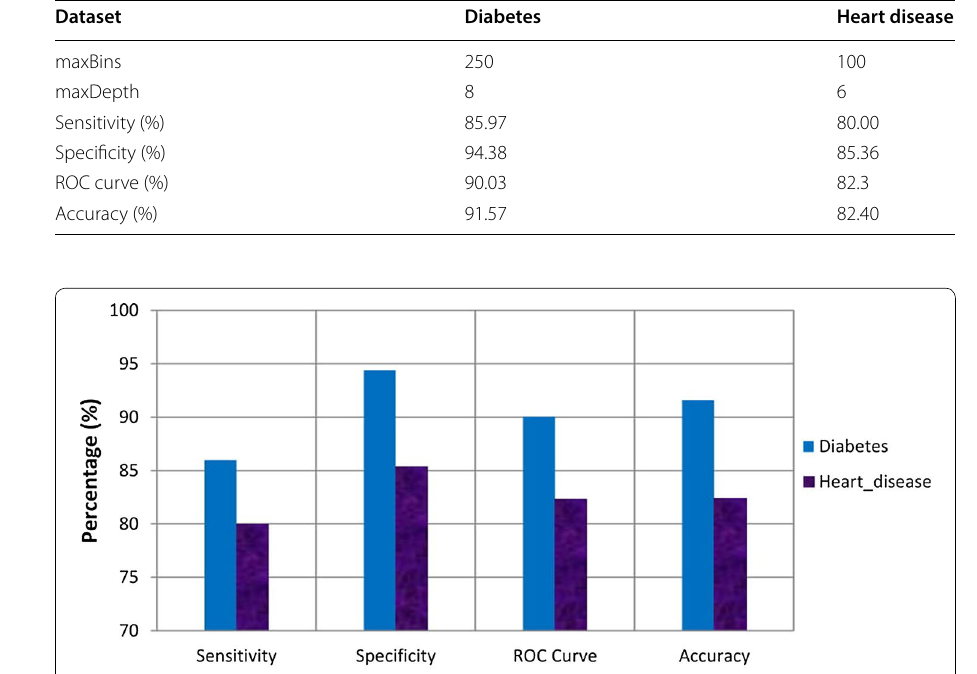
Fig. 8 Machine learning